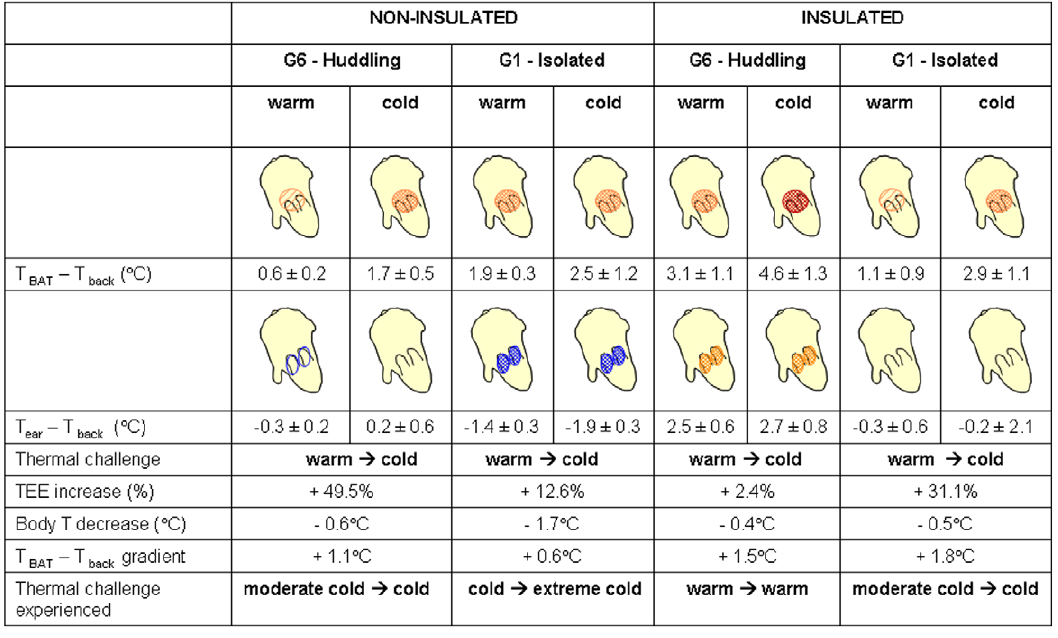
Figure 6. Gradients between brown adipose tissue (BAT) and back surface temperatures ( 6 C), and ear and back surface temperatures ( 6 C) for each pup category (G6 - huddling, G1 - isolated, non-insulated and insulated pups). The percentage increase in total Energy Expenditure (TEE) is based on Figure 2. Orange and red colours represent BAT and ear surface temperatures higher than back surface temperature (i.e. heat production or vasodilatation). Blue colours represent ear vasoconstriction. Denser shading represents higher surface temperature gradients.